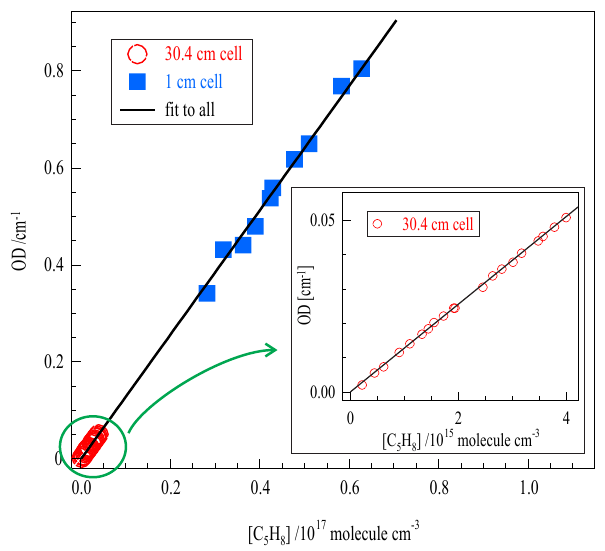
Figure 2. Beer–Lambert plot used to derive the cross section of isoprene at 184.95nm. An unweighted proportional fit to all the data yields σ isoprene = ( 1 . 28 ± 0 . 02 ) × 10 − 17 cm 2 molecule − 1 , rep- resented by the solid black line on both the main plot and insert. This value (also displayed as the red star in Fig. 1) was subsequently used to calculate isoprene concentrations for kinetic experiments.